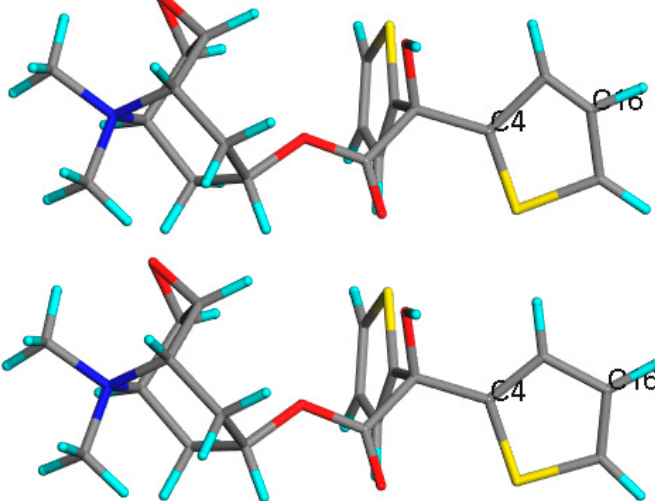
Figure 7. Results of GIPAW NMR calculations for tiotropium bromide monohydrate. On top is the experimental structure with solely hydrogen atoms positions optimized (188.54 ppm for C6 and 107.01 ppm for C12), below is the structure after all atom’s positions optimization (151.24 ppm for C6 and 127.64 ppm for C12). Experimental values: 148.91 ppm for C6 and 127.77 ppm for C12. Source: author’s archive, more details [207].